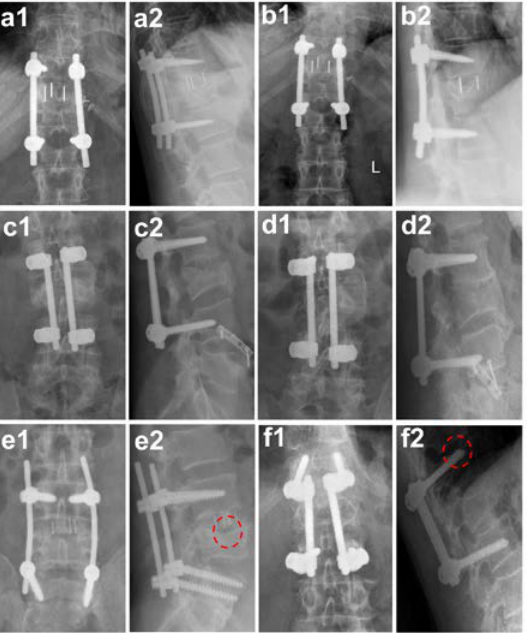
Figure 1. Fusion and non-fusion after surgical care. ( a , b ) Cage implantation; ( c , d ) autologous pelvic bone graft and subsequent bony fusion; ( a1 , b1 ) spine radiologically in anterior-posterior projection at different time points (( a1 ) post-operative; ( b1 ) follow-up after one year); ( a2 , b2 ) spine radiologically in lateral projection at different time points (( a2 ) post-operative; ( b2 ) follow-up after one year); ( c1 , d1 ) spine radiologically in anterior-posterior projection at different time points (( c1 ) post-operative; ( d1 ) follow-up after one year); ( c2 , d2 ) spine radiologically in lateral projection at different time points (( c2 ) post-operative; ( d2 ) follow-up after one year); ( e , f ) are controls after one year post-operative and show examples of non-fusion: ( e ) shows a hypodense area around the implanted cage (( e1 ) anterior-posterior projection and ( e2 ) lateral projection; see hypodense area marked with dashed circle in red); ( f ) shows the loosening and cutting-out of the screws in the area of the cover plate of the vertebral body after autologous pelvic bone graft insertion (( f1 ) anterior-posterior projection and ( f2 ) lateral projection; see cutting-out of the screws marked with dashed circle in red).